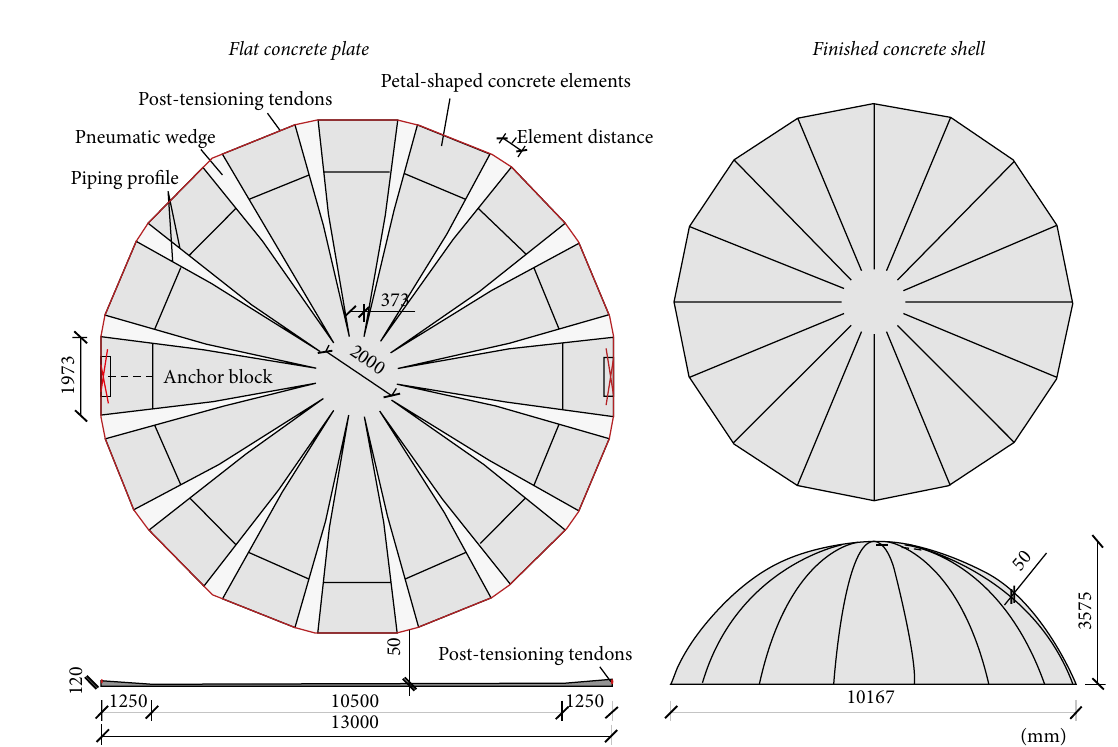
Figure 20: Dimensions for the erection of a spherical shell (large-scale